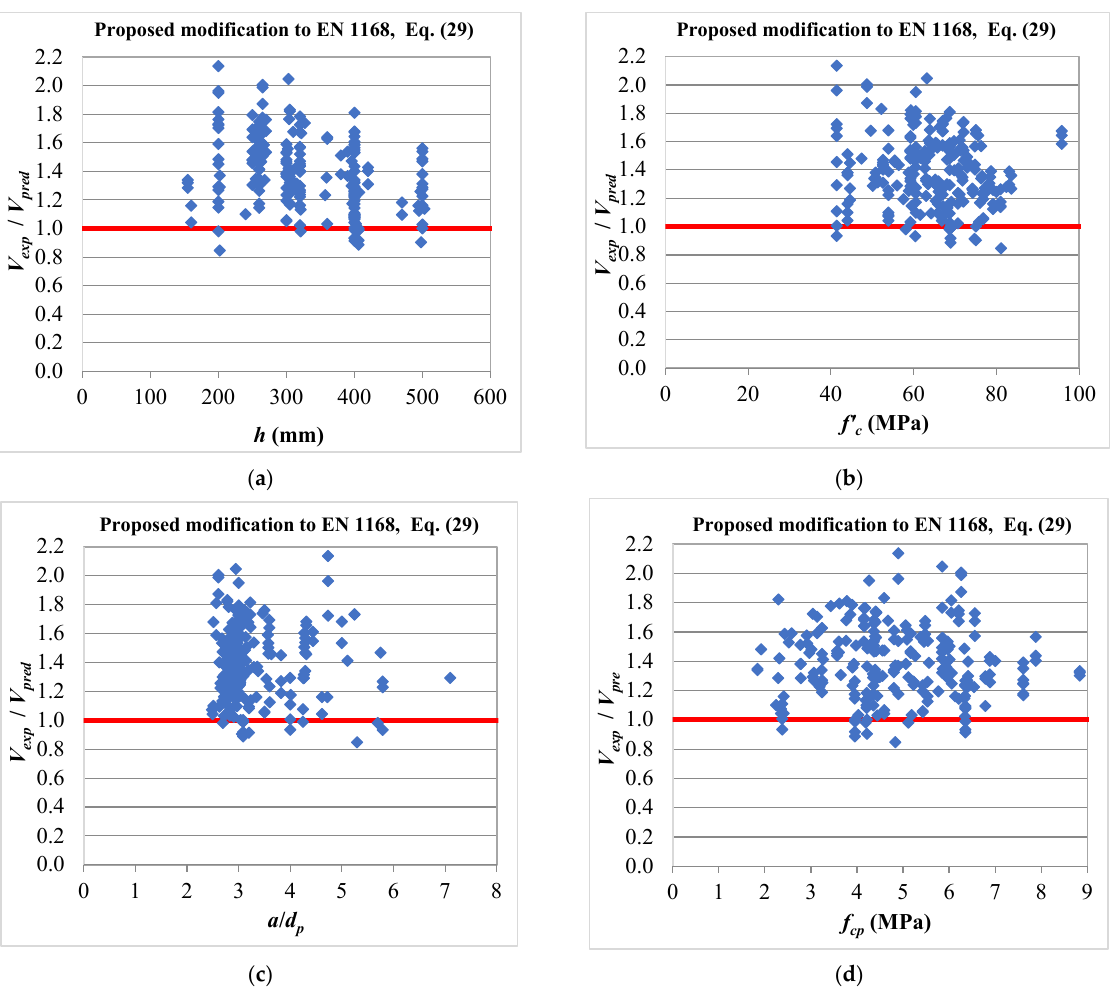
Figure 18. Predictions of Equation (29) against ( a ) total thickness, ( b ) concrete compressive strength, ( c ) shear span to depth ratio, and ( d ) compressive stress due to the fully effective prestressing force.